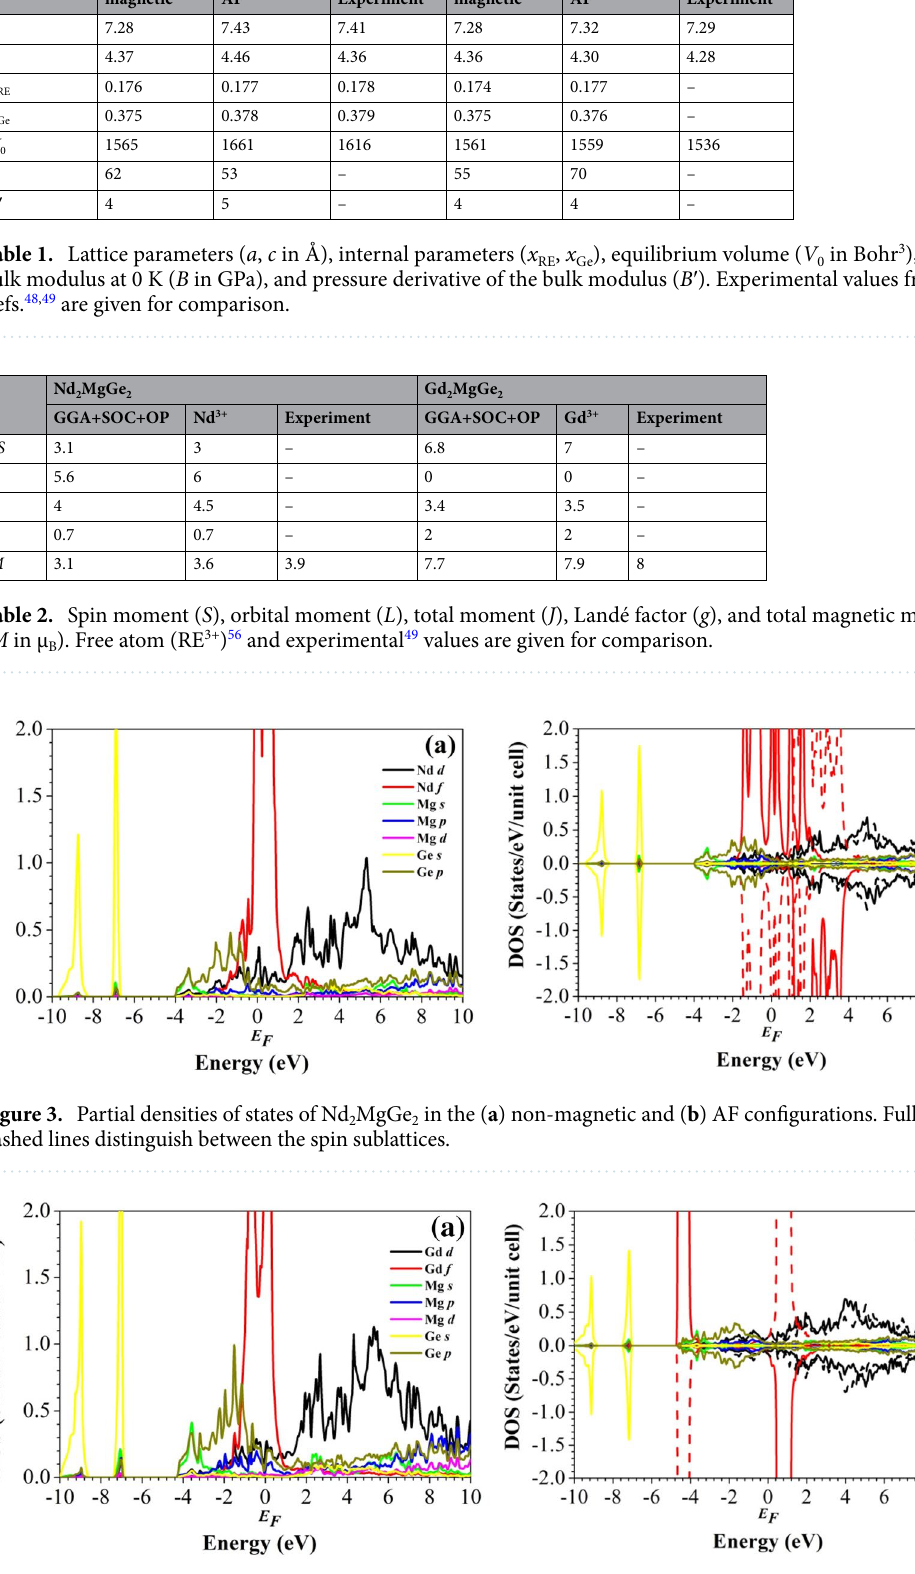
Figure 4. Partial densities of states of Gd 2 MgGe 2 in the ( a ) non-magnetic and ( b ) AF configurations. Full and dashed lines distinguish between the spin